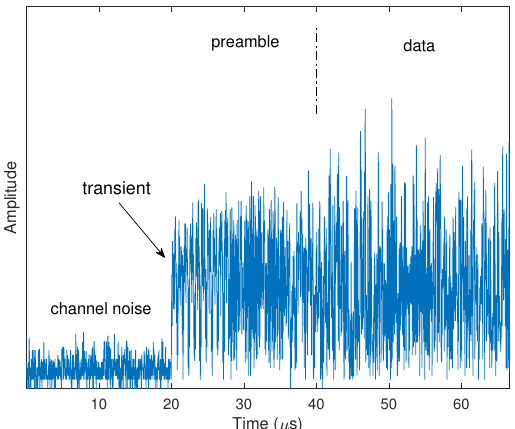
Figure 2. Instantaneous amplitude of a captured IEEE 802.11n signal collected at the 2.4 GHz ISM